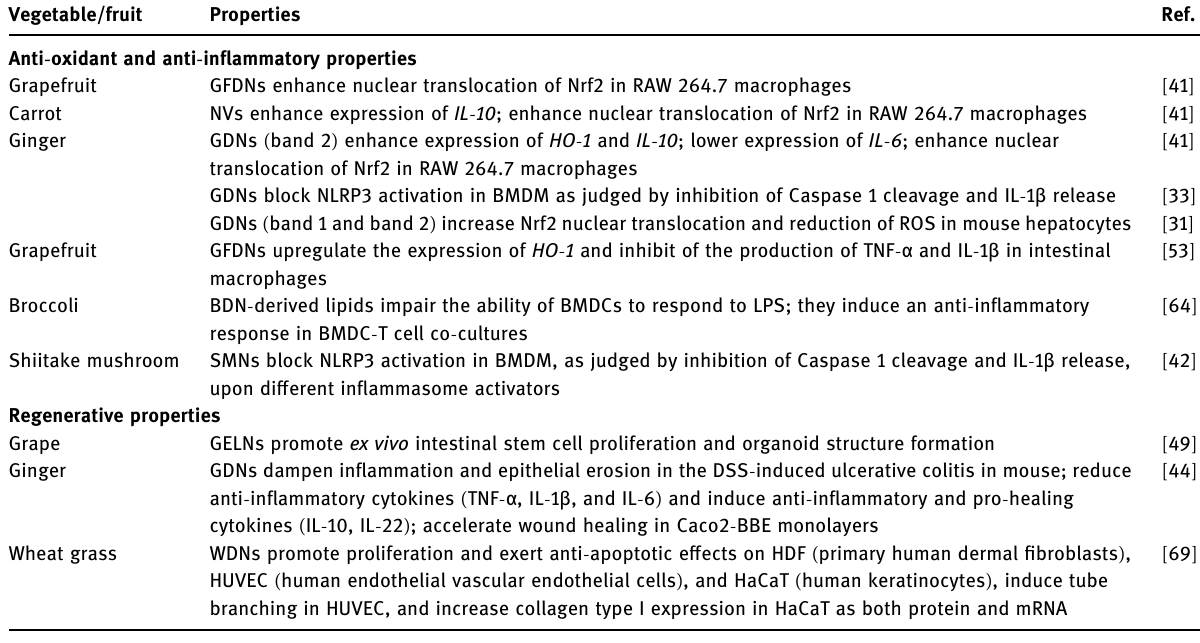
Table 2: Anti - oxidant, anti - in fl ammatory, and regenerative properties of plant - derived nanovesicles